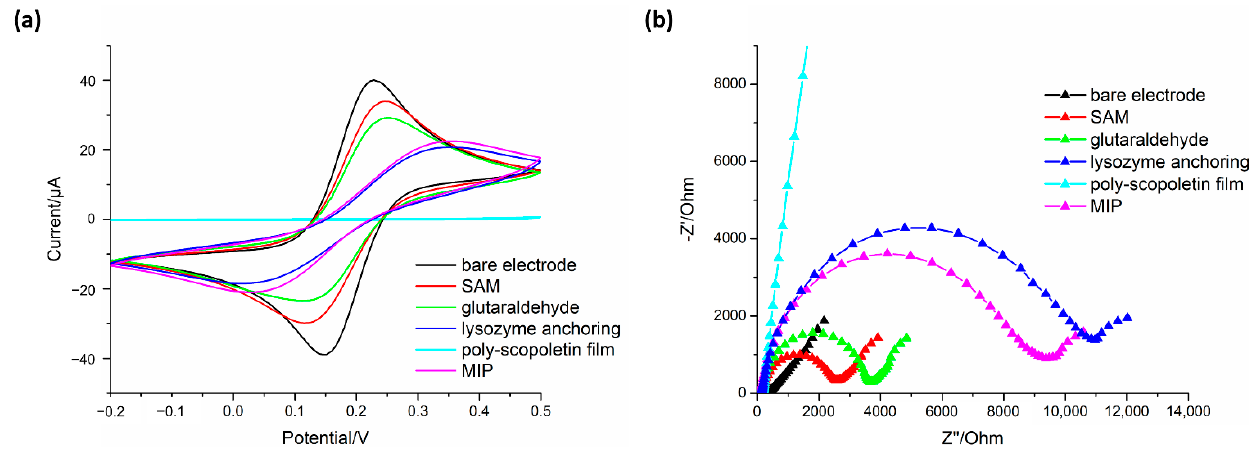
Figure 3. ( a ) Cyclic voltammograms (scan rate 100 mV/s) and ( b ) EIS Nyquist plots recorded in 5 mM [Fe(CN) 6 ] 3 − / 4 − redox couple prepared in 50 mM phosphate buffer with KCl 0.1 M, to check the electrode functionalization in MIP 2 synthesis. “Polyscopoletin film” and “MIP” refer, respectively,